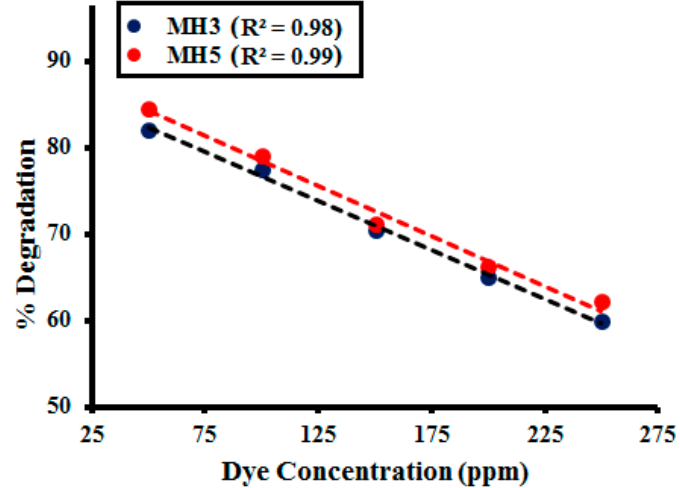
Figure 9. Correlation between different dye concentrations (50–250 ppm) and percentage degradation of alizarin red (AR) dye by 0.025 g of nanomaterials MH1 and MH5 after 60 min of photocatalytic activity.